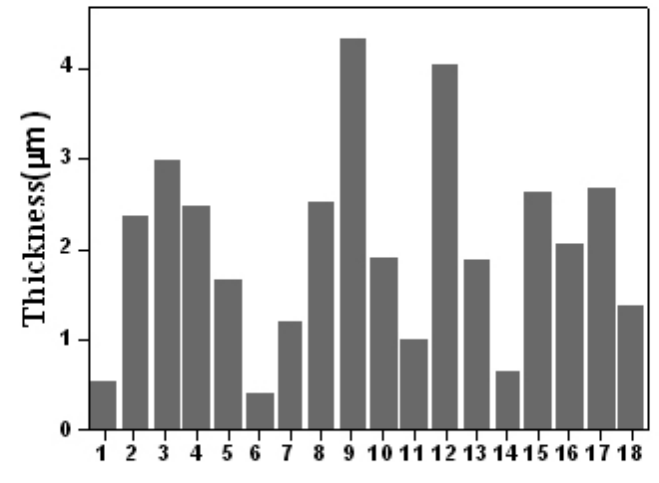
Figure 2. Average thickness of No.1~18 samples.